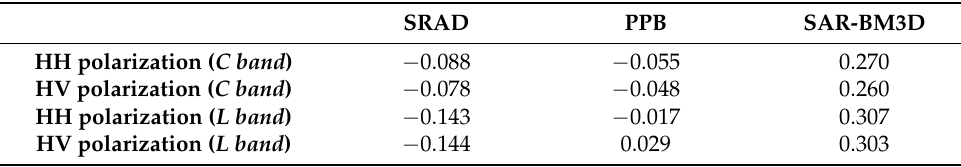
Figure 8. Filtering results for the AirSAR dataset (first row: speckled images; second row: SRAD filtered images; third row: PPB filtered images; fourth row: SAR-BM3D filtered images). ( a ) HH polarization of C band. ( b ) HV polarization of C band. ( c ) HH polarization of L band. ( d ) HV polarization of L band. Table 6. RGPI values for the AirSAR dataset.